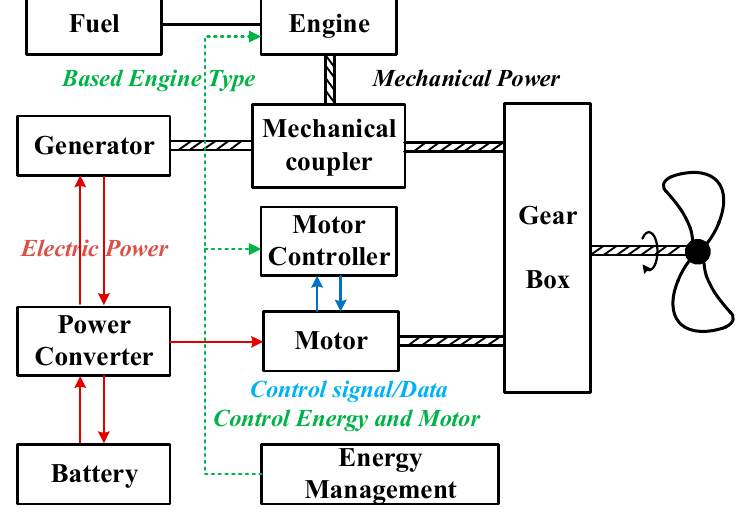
Figure 13. Series-Parallel Hybrid.